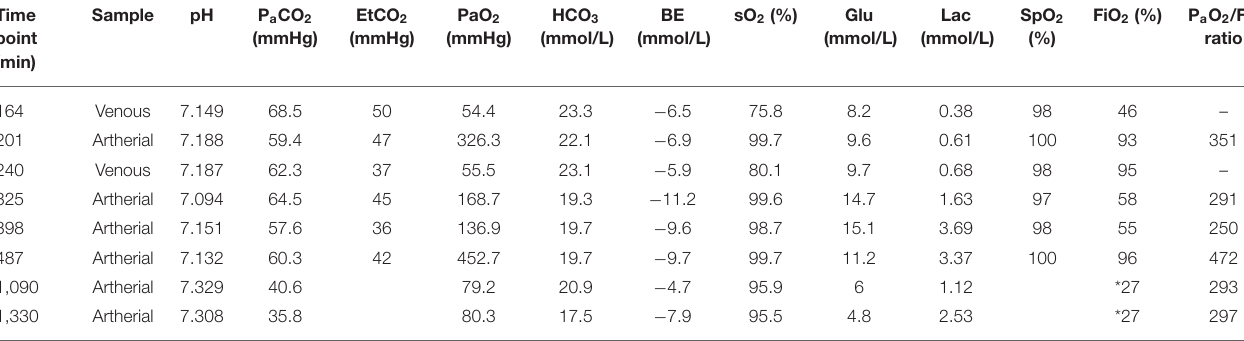
TABLE 1 | The table summarises six intraoperative and two postoperative blood gases performed. Time point (min)